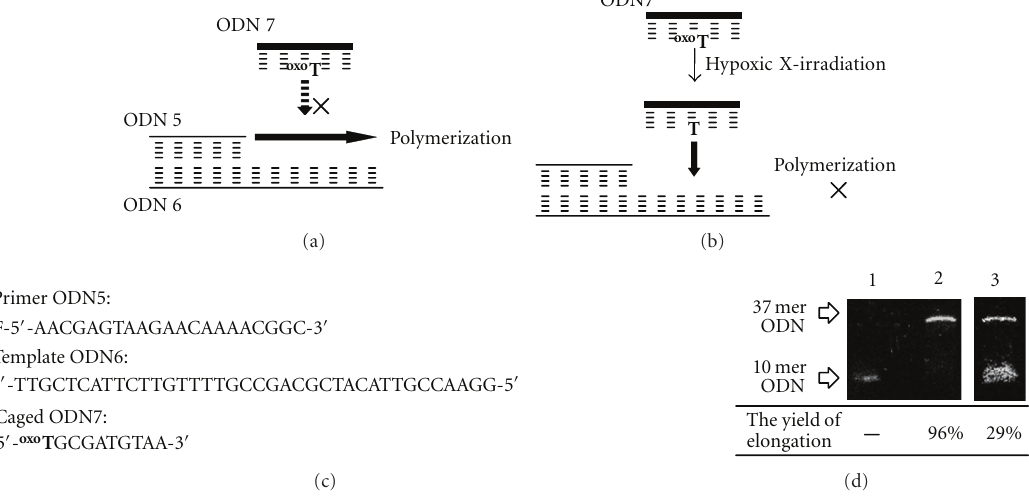
Figure 5: (a,b) Schematic illustration of regulation of DNA polymerase reaction by X-irradiation. The reaction in the presence of caged ODN 7 before X-irradiation (a) or after X-irradiation (b). (c) Sequences of oligodeoxynucleotides used for DNA polymerase reaction. (d) Representative gel electrophoresis of DNA elongation by the Klenow fragment of DNA polymerase I. ODN 7 (100 μ M) was X-irradiated (1200Gy) under hypoxic conditions, and then ODN 6 (5 μ M), fluorescein-labeled ODN 5 (5 μ M), and enzyme (0.2unit) were added. After the incubation for 15min at 32 ◦ C, the elongation was monitored by gel electrophoresis. Lane 1: marker (20mer), Lane 2: the ODN 7 was added before X-irradiation. Lane 3: the ODN 7 was added after X-irradiation